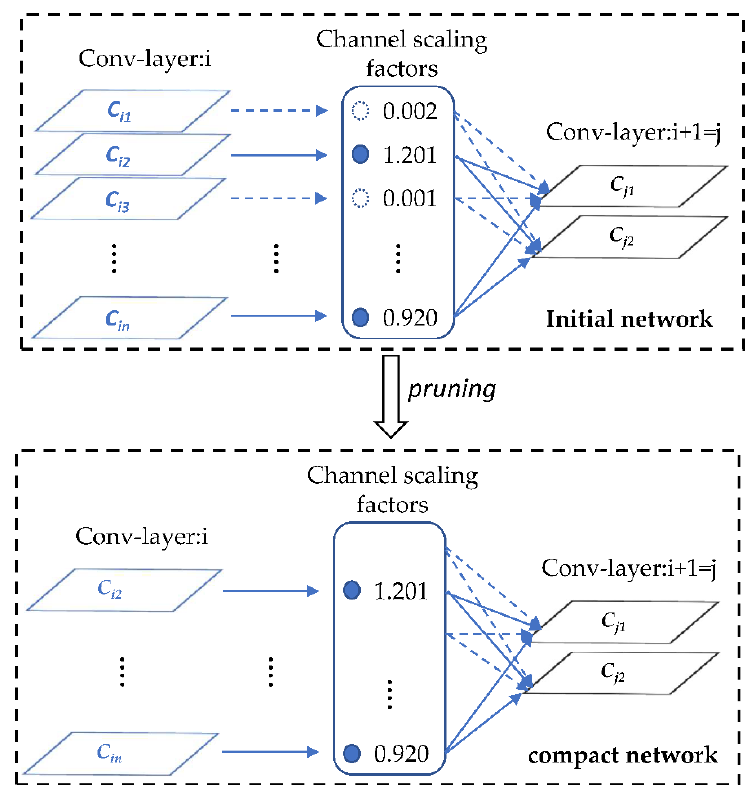
Figure 6. Principle of pruning.